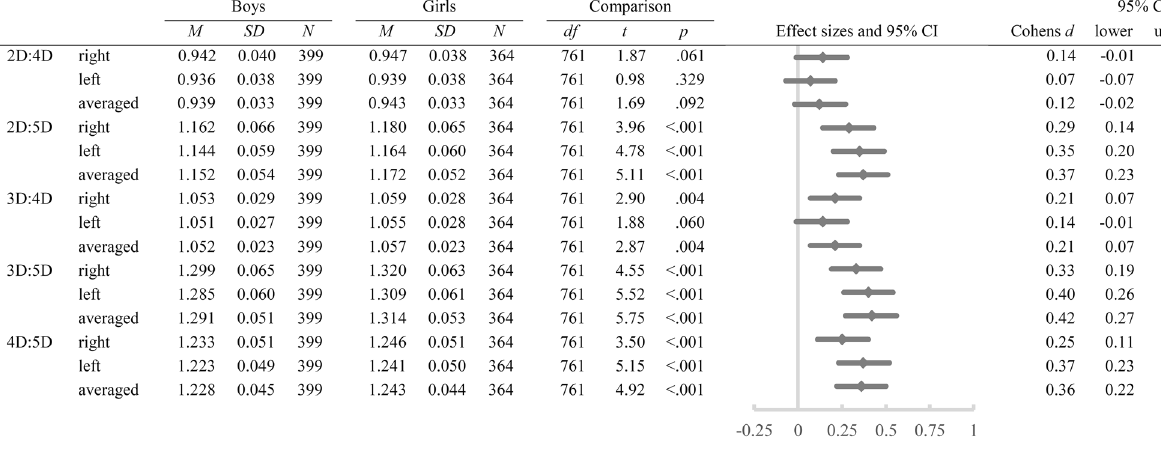
Table 3. Means, standard deviations, post -hoc t - tests, and effect sizes for sex differences in digit ratios of both hands ( N = 763).